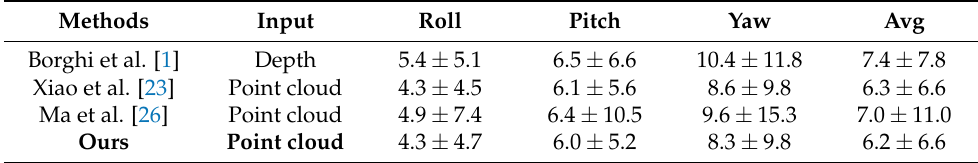
Table 5. Comparison of results achieved by different methods on the Pandora dataset. Methods